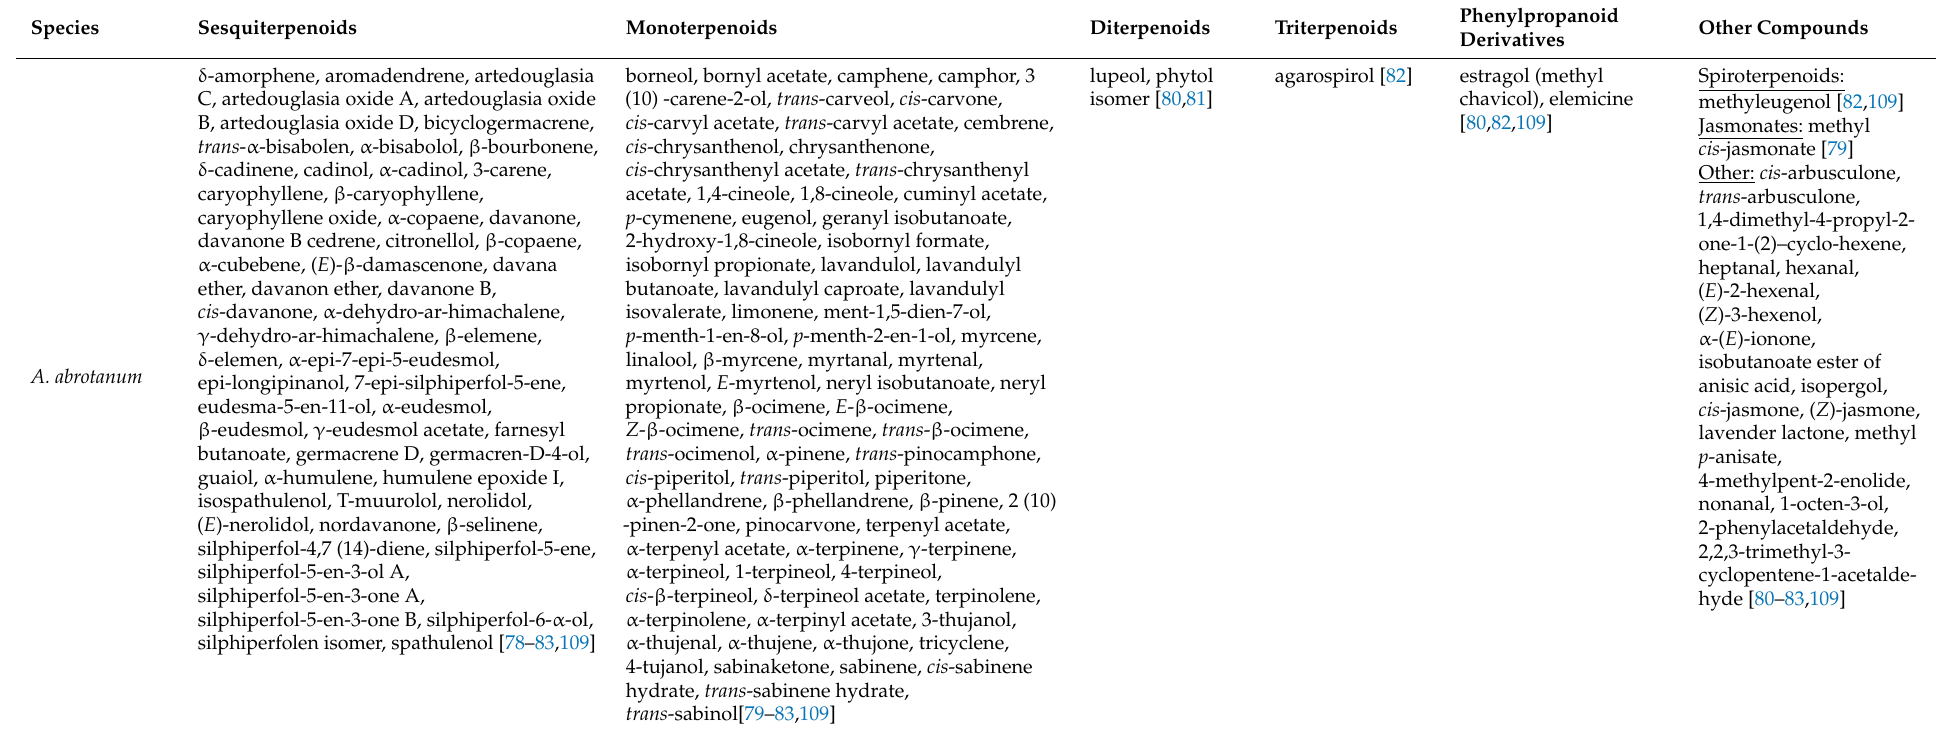
Table 3. Chemical composition of essential oil from Artemisia